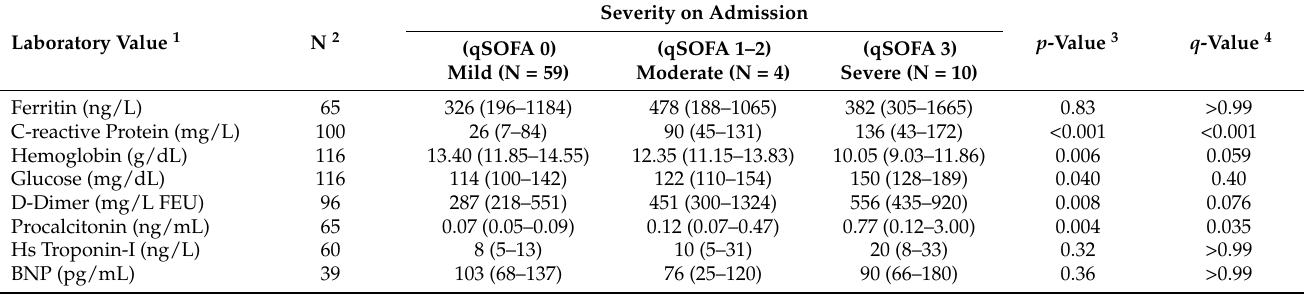
Table 2. Laboratory findings of COVID-19 patients.